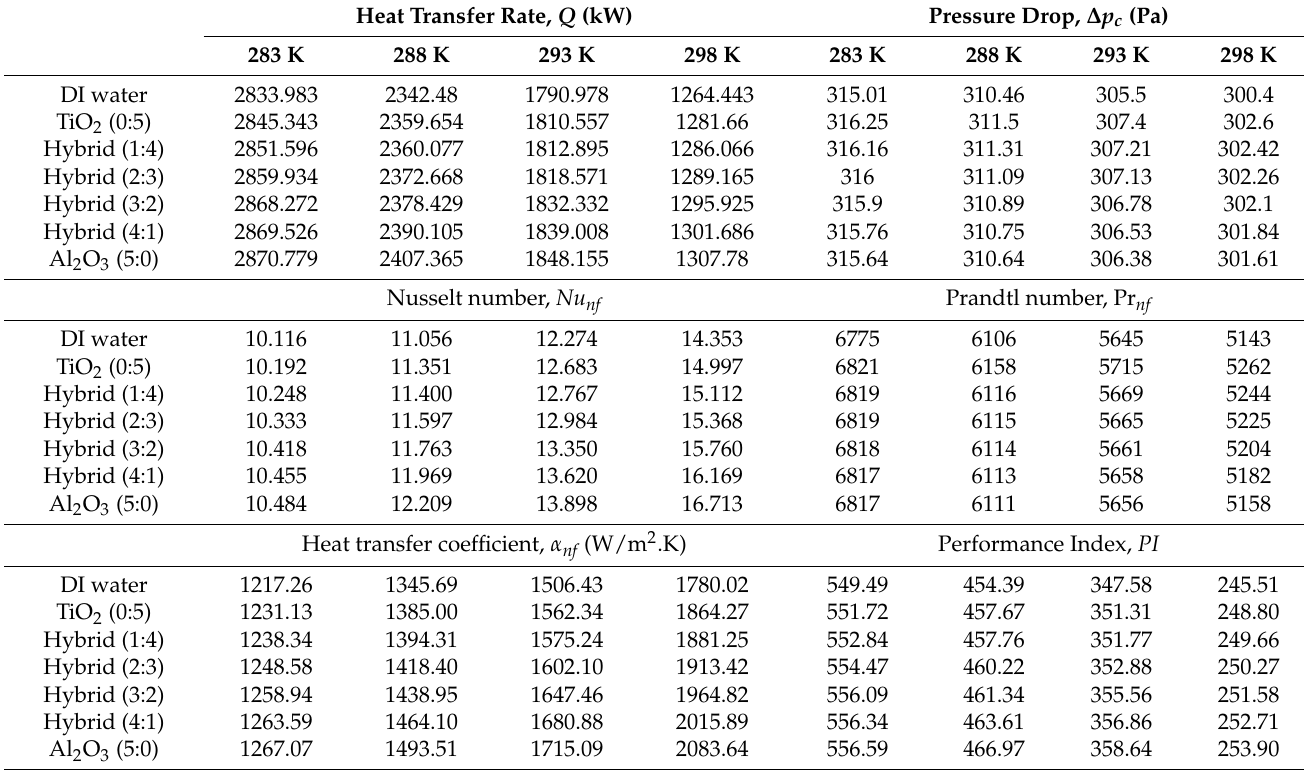
Table 10. Performance parameters varying coolant inlet temperature from 283 K to 298